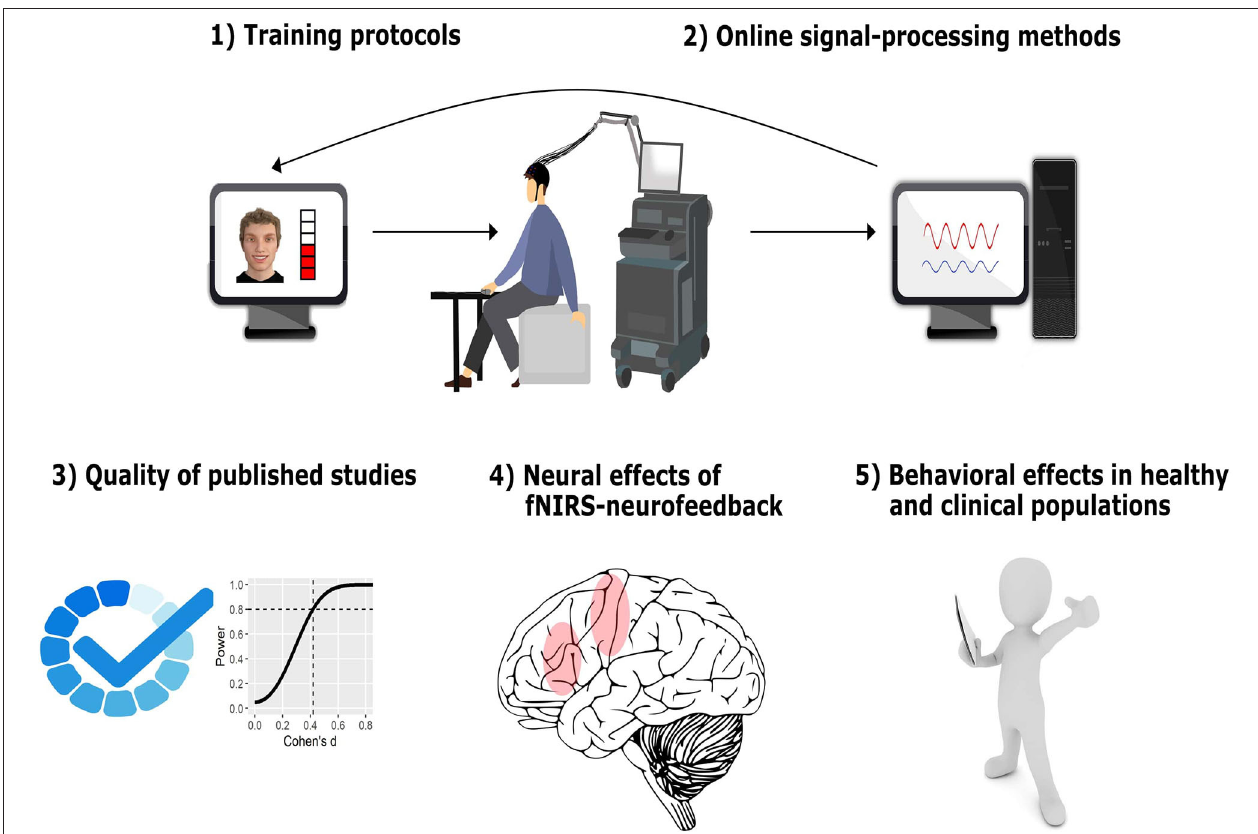
FIGURE 2 | Structure of results and discussion. In the first two sections, we provide a comprehensive overview of how fNIRS-neurofeedback training is implemented, describing and discussing important features of neurofeedback-training protocols (1) and of the real-time signal-processing methods applied (2). In the third section, we critically evaluate the quality of published studies including experimental design and reporting quality as well as statistical power/sensitivity as an indicator of reliability of the reported findings (3). In the fourth section, we assess and discuss the effectiveness of fNIRS-neurofeedback to regulate and induce pre-post changes in brain activity (4). Finally, we assess and discuss its effectiveness in changing behavioral outcomes and we review the clinical potential of fNIRS-neurofeedback (5). The fNIRS illustration was created by Laura